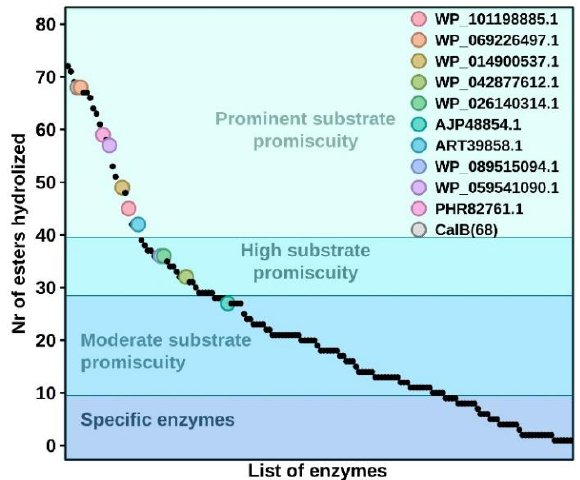
Figure 5. The ranking of all ten characterized hydrolases in terms of promiscuity. The number of substrates converted by each of the ten hydrolases herein reported compared to that of other 145 ester hydrolases previously characterized, using the same set of esters herein tested. This figure is created from data previously reported [4] and data herein reported for the ten hydrolases. Table 2. Kinetic parameters of selected hydrolases for p- NP propionate. The results are the mean ± SD of triplicates. Note: Kinetic parameters could not be determined (n.d.) because no reliable K m could be determined (low affinity for the substrate under our experimental conditions).